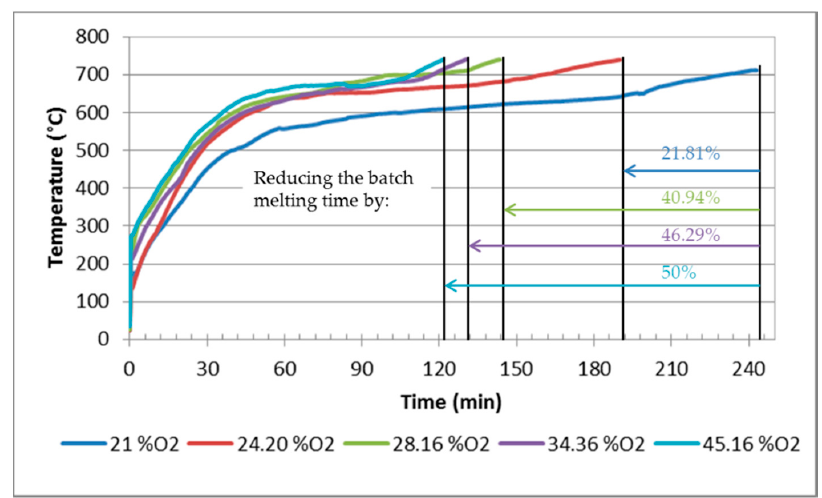
Figure 8. Temperature of the charge during the process of aluminium ingot melting as a function of the oxygen concentration, using the ordinary air nozzle.